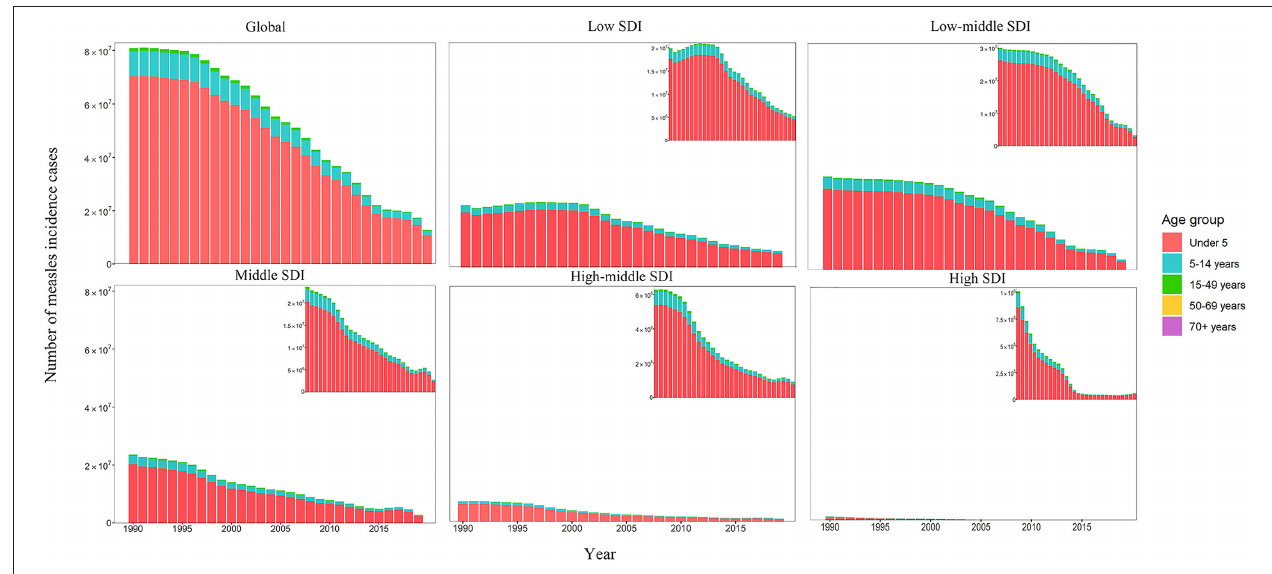
FIGURE 1 | The number of measles incidence cases by age groups and SDI regions. SDI: socio-demographic